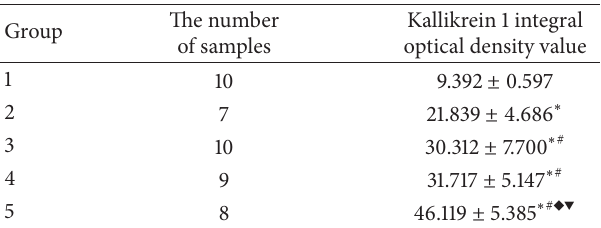
Table 2: Expression of kallikrein 1 in renal tissue. The number Group of samples